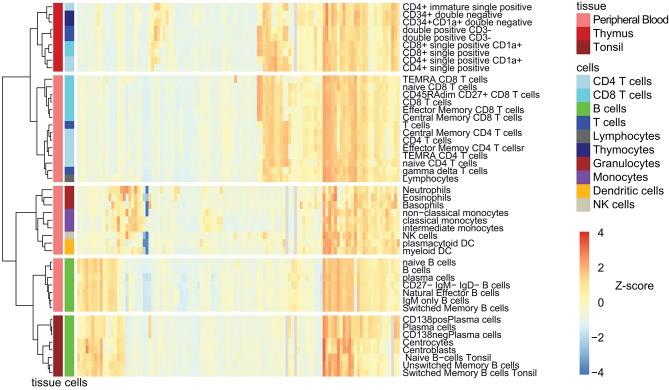
Hierarchical clustering analysis of CD marker expression on leukocyte subsets. Unsupervised clustering was performed on all CD markers (n = 117) and all cell subsets (n = 47) based on log10 transformed Median ABC. Cell subsets are color coded based on their lineage and their tissue of origin. Hierarchical tree was algorithmically cut into clusters (k = 5). Each cell subset group could contain cell subset from one or more tissue type (peripheral blood, thymus, and tonsil). See Supplementary Figure 8 for larger version of this figure, including CD marker labeling.